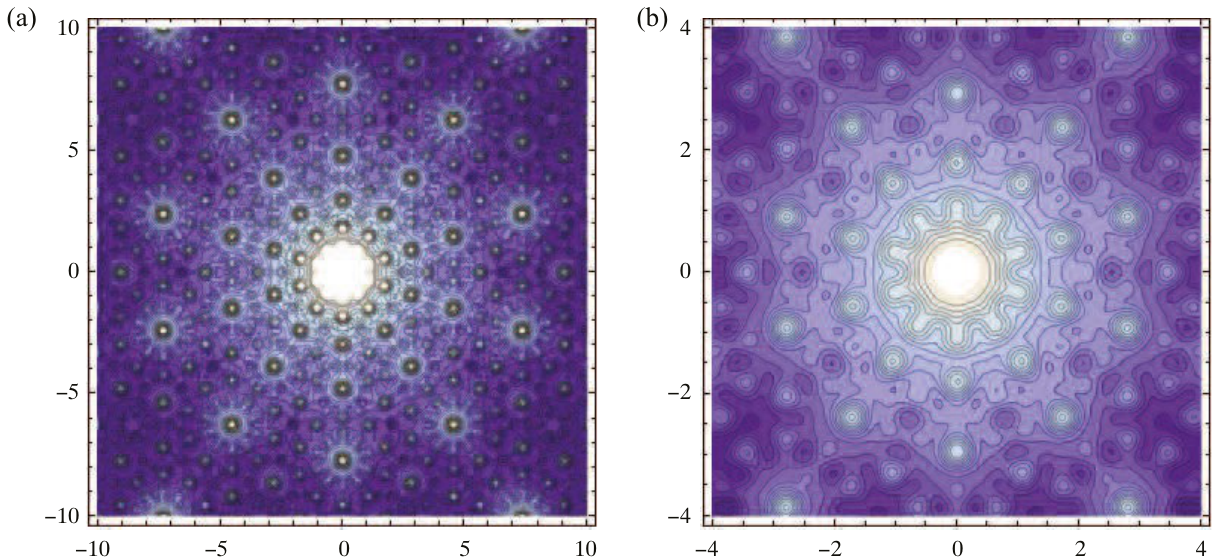
Figure 6. The k -plane is colored (with 20 levels) to show | ( k )|, where the Fourier transform ( k ), given by Eq. (45), arises from the mass distribution (44). Lighter shades represent larger values of | ( k )|. (a) –10 ≤ k 1 , k 2 ≤ 10; (b) –4 ≤ k 1 , k 2 ≤ 4. For the convergence factor a | m | we have taken a =